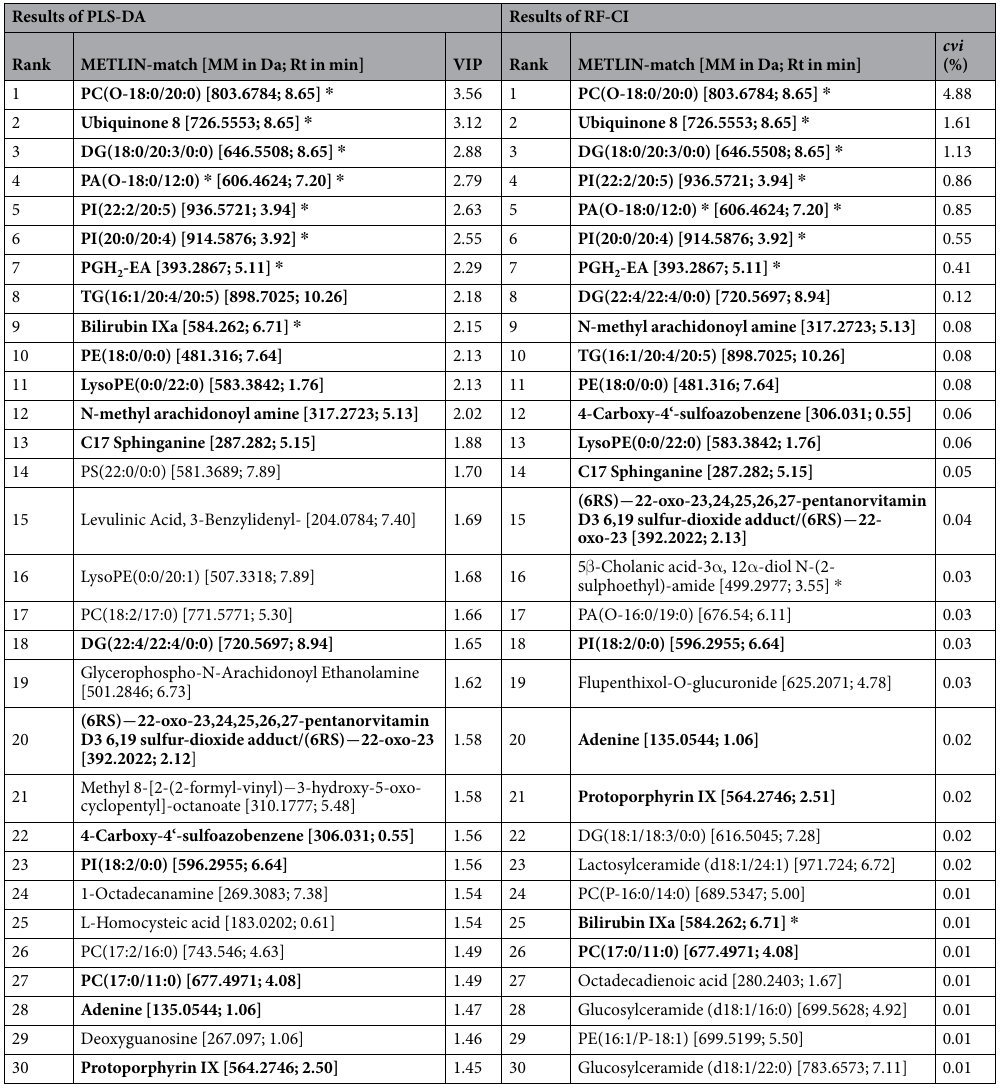
Table 3. Variable importance scores for the 30 top-ranked METLIN-matched compounds in PLS-DA and RF-CI predicting a history of CM. The first 30 top-ranked metabolites for the Partial Least Squares- Discriminant Analysis (PLS-DA) and random forests embedded in a conditional inference framework (RF-CI) are presented, displaying the respective importance of the candidates in the prediction of class membership (CM + or CM − ). For PLS-DA, Variable Importance in Projection (VIP) is provided, whereas conditional variable importance ( cvi ), representing the averaged mean decrease in accuracy, is stated for RF-CI. Bold highlighted metabolites popped up in the top 30 of both PLS-DA and RF-CI. Metabolites marked with an asterisk became significant in the univariate group comparisons after multiple testing correction. Da = Dalton; MM = Monoisotopic mass; Rt = Retention